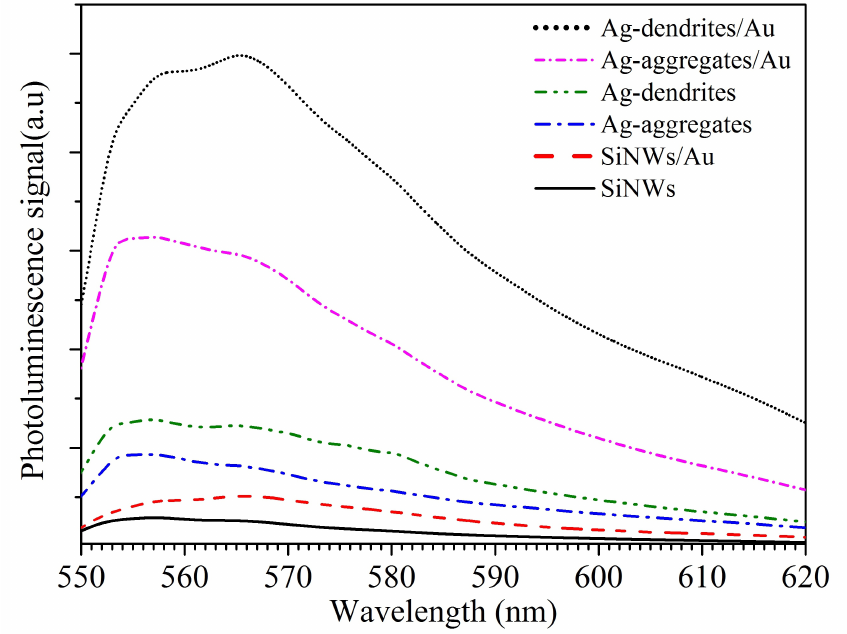
Figure 5. Photoluminesence spectra with a green laser excitation (532 nm) of the R6G analyte on the different substrates fabricated in this